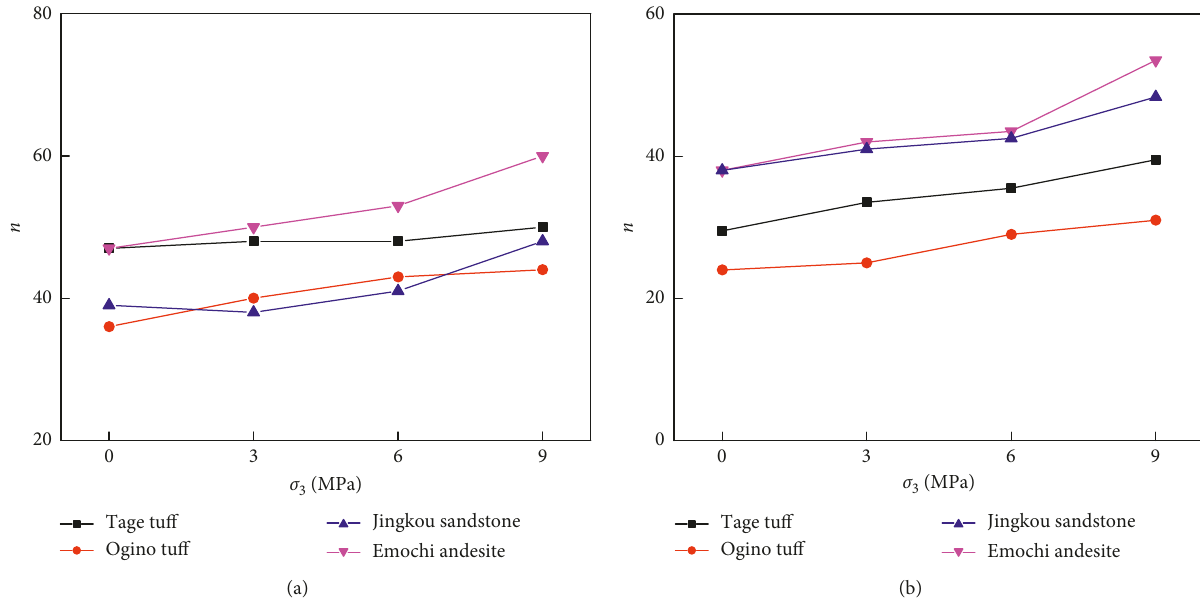
Figure 8: Loading-rate dependence index of peak strength with respect to confining pressure under (a) air-dried, (b) wet conditions.